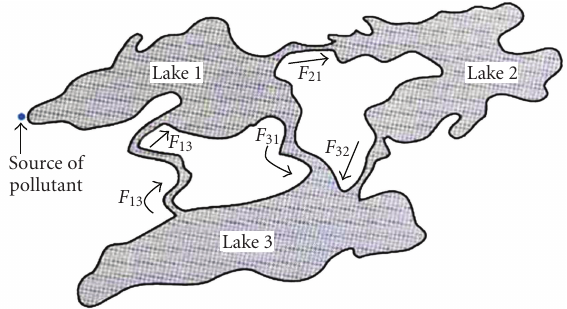
Figure 1: System of three lakes with interconnecting